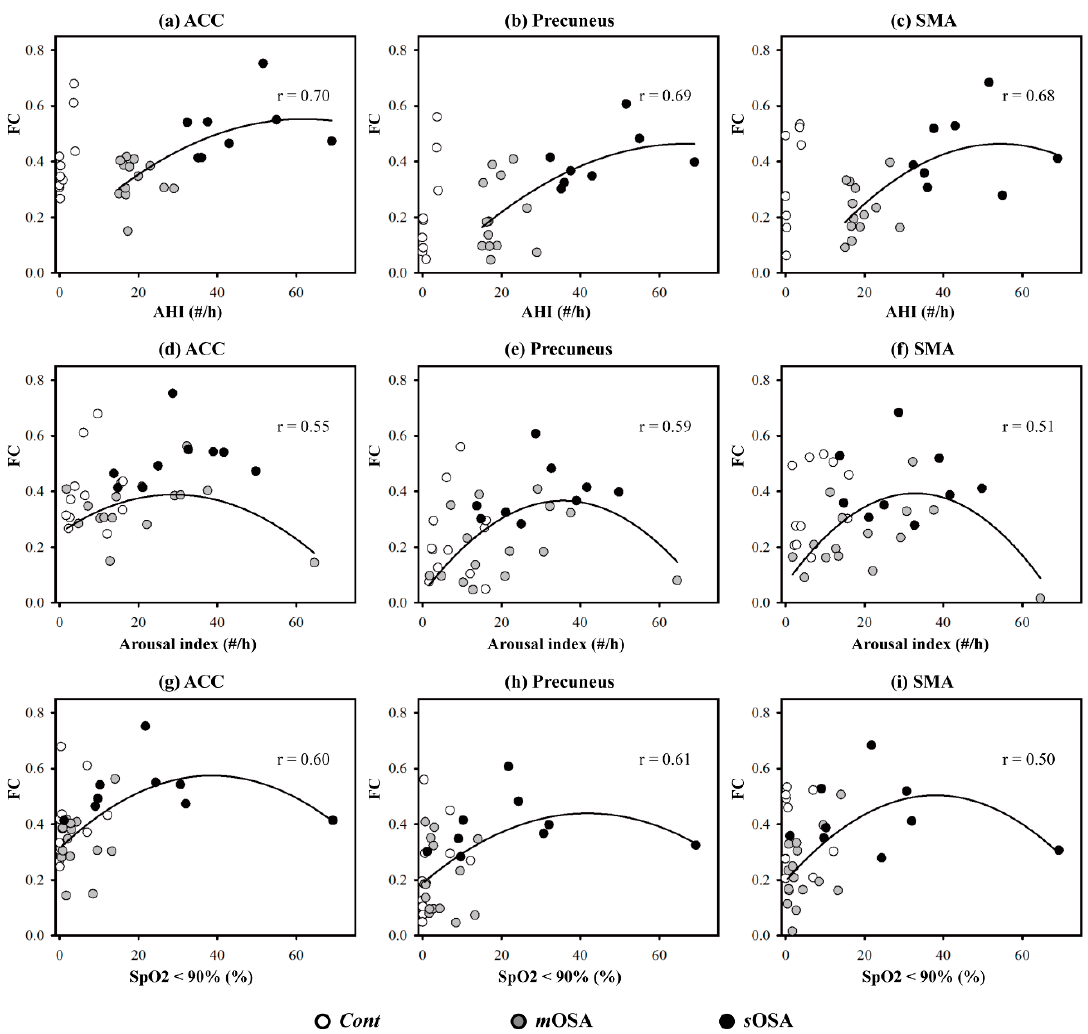
Figure 5. Scattering plot of PSG parameters and functional connectivity. Three regions of interest—the ACC ( a , d , g ), the precuneus ( b , e , h ), and the SMA ( c , f , i ), are demonstrated in each column, and three PSG parameters, including the AHI ( a – c ), the arousal index ( d – f ), and SpO 2 ( < 90%) ( g – i ), are presented in each row. Curve fitting was performed with quadratic regression across patients. The fitness value of all the curves was expressed with the correlation intensity. Functional connectivity and PSG parameters exhibited good fitness with a quadratic regression across patients, particularly for the parameter AHI. The tendency of the distribution implied that functional connectivity would become stronger from m OSA to s OSA, and that it would decline when the OSA symptom worsened. Abbreviation: AHI, apnea-hypopnea index; FC, functional connectivity; Cont , Control group; m OSA, moderate OSA group; s OSA, severe OSA group; ACC, anterior cingulate cortex; SMA, supplementary motor area; OSA, obstructive sleep apnea; PSG, polysomnography.